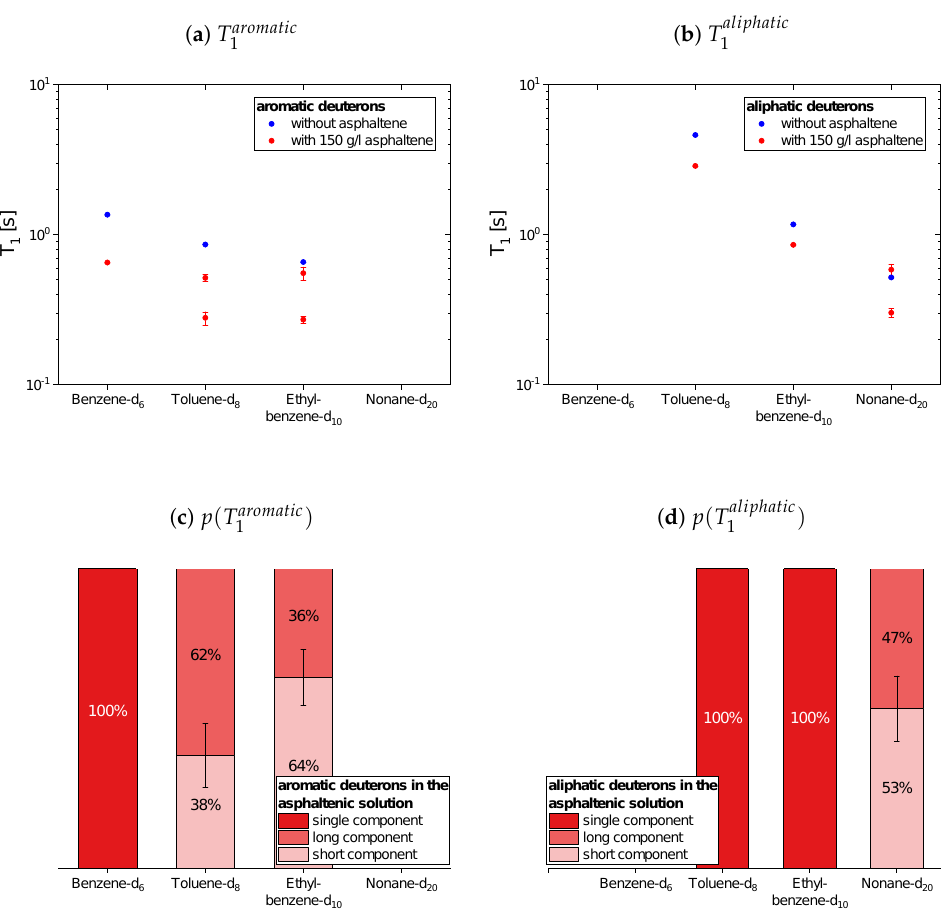
Figure 10. Top: Longitudinal relaxation time constants T 1 of the aromatic ( a ) and aliphatic ( b ) deuterons in the asphaltene-free and the asphaltenic solution. Bottom: Relative weight of the T 1 components of the aromatic ( c ) and aliphatic ( d ) deuterons in the asphaltenic solution. The x-axis distinguishes the different solutions, consisting of 5vol% of the specified maltene and 95vol% benzene without or with 150g/L